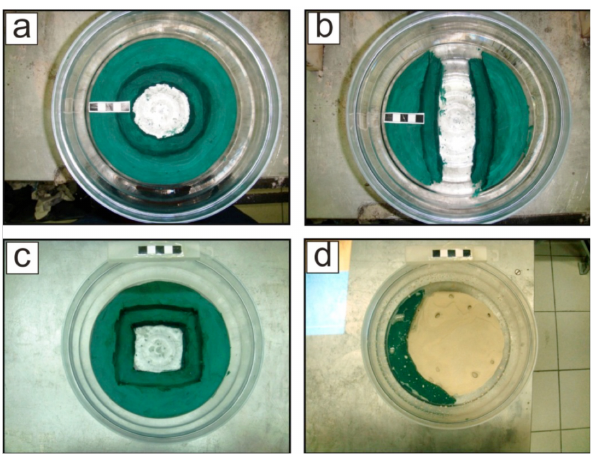
Figure 3. Photographs of the experimental setup showing the plas- ticine molded to produce variations in the geometry of the rigid country rock. The bowl was then filled to the level of the plasticine with gravel and covered with hollow glass microbeads to obtain a plain surface. (a) Ring faults circular, (b) parallel faults simulating a magmatic dike shape, (c) ring faults square, (d) asymmetric faults set